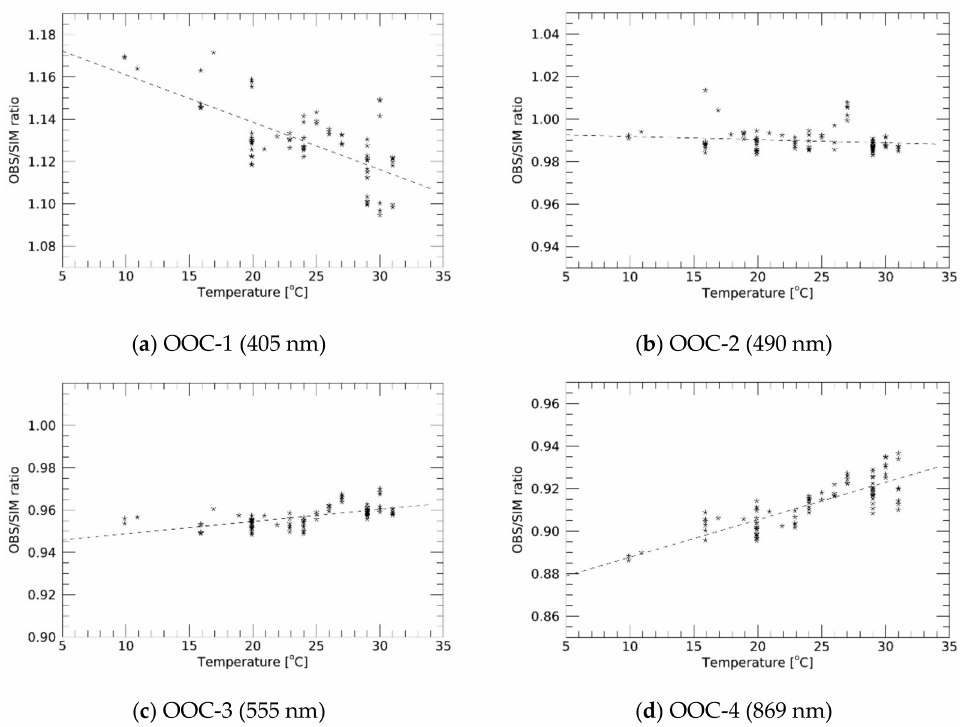
Figure 8. Observation-to-simulation irradiance ratio (OSR) scatters as a function of the sensor temperature. Dashed lines are the results of the linear